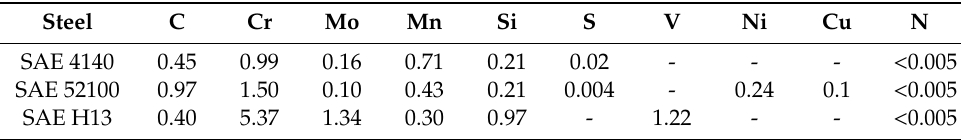
Table 1. Mean chemical composition determined for the three applied steels (in